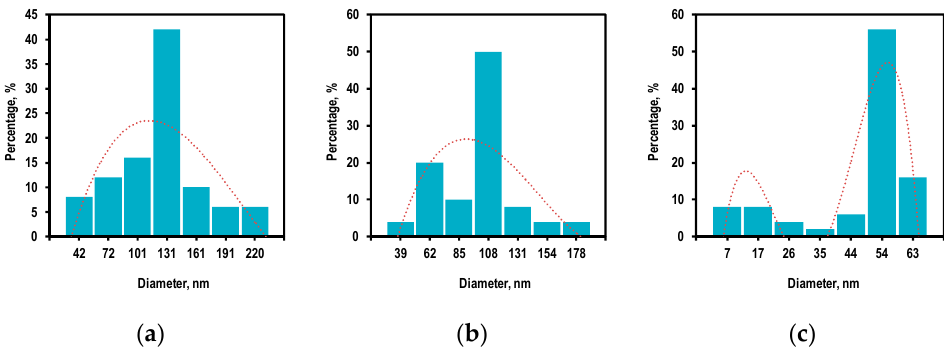
Figure 4. The transverse size distribution of the ZnO structures obtained by the PECVD method at the various zinc source temperatures: ( a ) 370 °C, ( b ) 420 °C, ( c ) 470 °C.